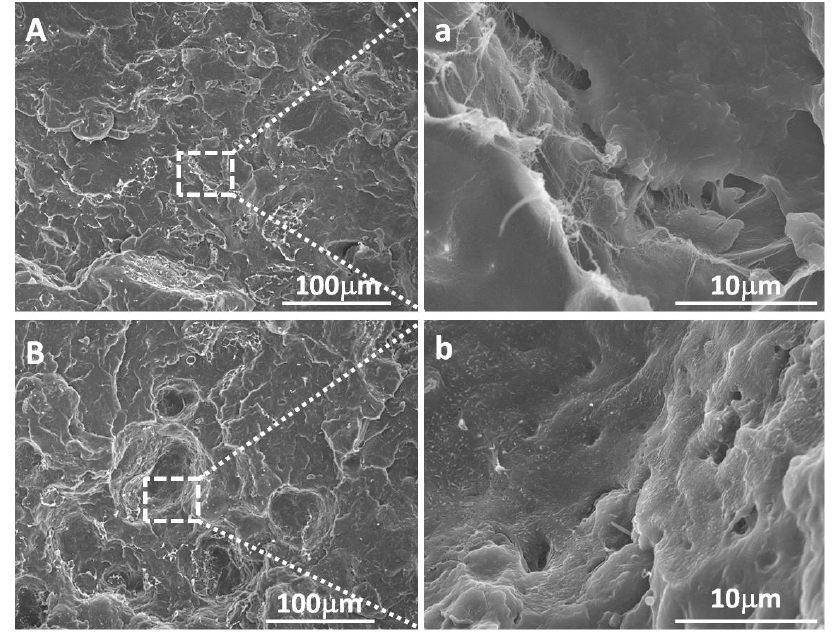
Figure 1. SEM images of fracture of UHMWPE/PP 85/15: by TSE ( A,a ). and by ERE( B,b ).( a – b ) represent the corresponding enlarged area in ( A – B ).